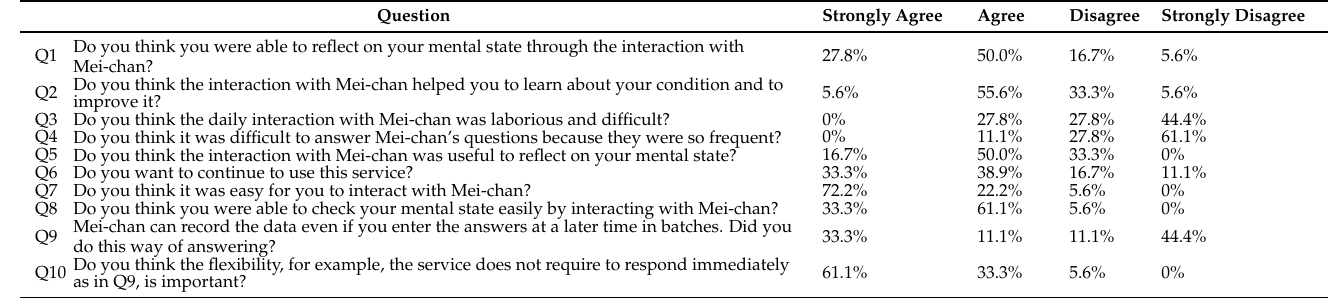
Table 5. Results of